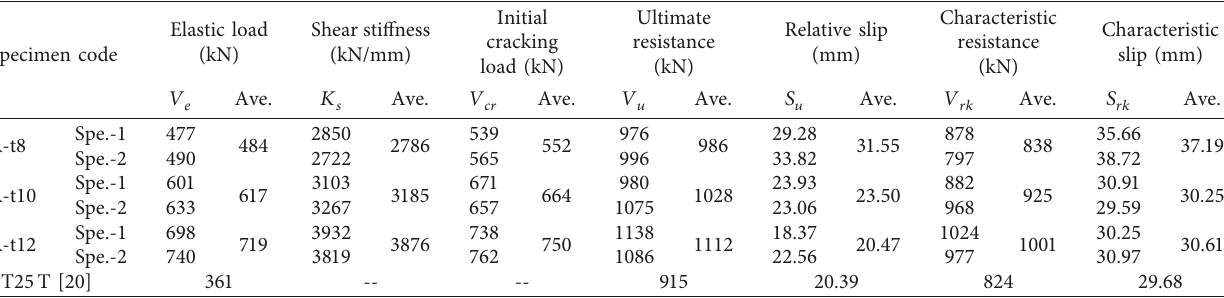
Figure 6: Failure patterns for components in concrete slabs: (a) perforated steel plates; (b) reinforced concrete dowel by the hole; (c) transverse steel rebars by the hole; (d) perforated steel plates for PBL using normal aggregate concrete. Table 3: Push-out test summary